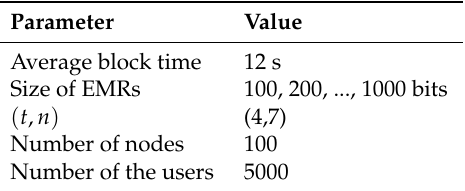
Table 2. Simulation